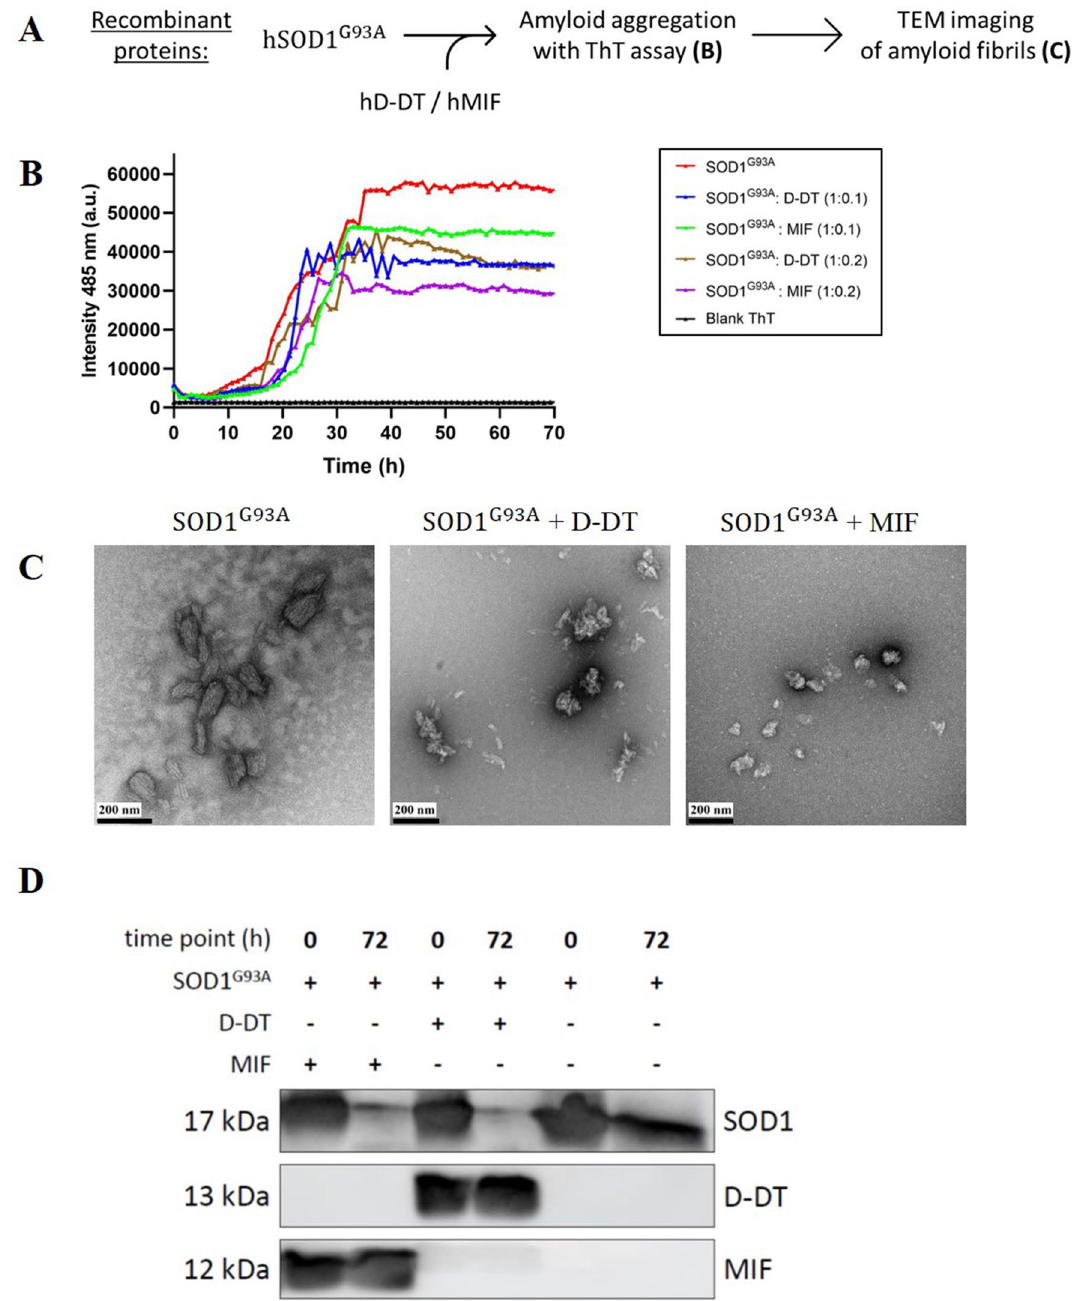
Figure 1. Recombinant D-DT inhibits the formation of mutant SOD1 G93A amyloid aggregates . ( A ) Schematic representation of the experimental protocol for determining whether recombinant D-DT, as compared to MIF, suppresses the amyloid aggregation of mutant SOD1. ( B ) ThT fluorescence was monitored for 70 h during the incubation of mutant SOD1 G93A (50 µM, red), either alone, or in the presence of recombinant D-DT (5 µM, blue; 10 µM, brown), or MIF WT (5 µM, green; 10 µM purple). ( C ) TEM images of a SOD1 G93A (50 µM) incubated alone, or in the presence of recombinant D-DT (10 µM) or MIF WT (10 µM). ( D ) Immunoblot showing the SOD1 monomer before and 72 h after incubation in aggregation inducing conditions alone or in the presence of recombinant human MIF or human shows a similar inhibition at 5 µM or 10 µM (Fig. 1B). Incubating D-DT alone did not generate an increase in turbidity (Figure S2) or in the ThT signal, during 70 h of incubation (Figure S3). Recombinant D‑DT does not reduce mutant SOD1 G93A misfolding. We have previously shown that MIF inhibits the accumulation of misfolded SOD1, both in vitro and in vivo 39,40,42 . Moreover, we demonstrated that MIF N110C , a previously reported cysteine mutant of MIF, which covalently locks MIF into its stable trimeric